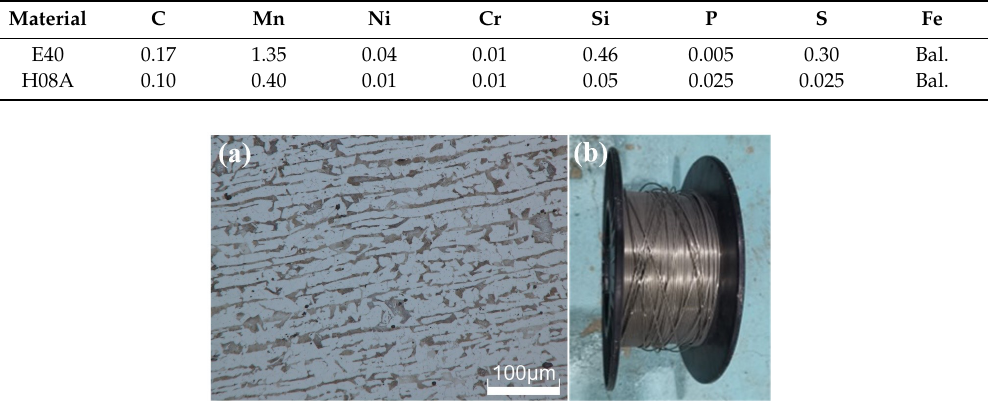
Figure 2. ( a ) Microstructure of EH40 base metal. ( b ) A coil of finished welding wire.